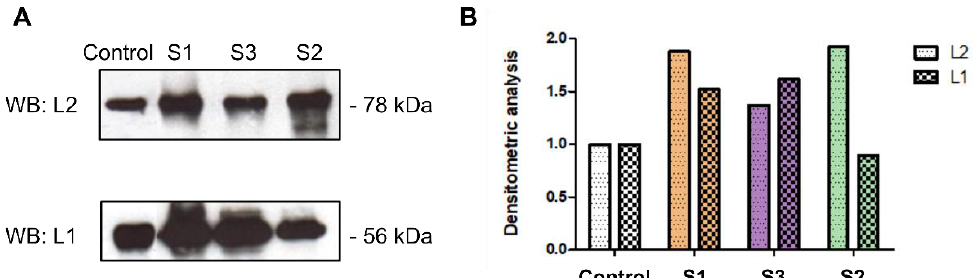
Figure 2. Effect of crude C. majus latex, protein fraction, and alkaloid-rich fraction on HaCaT cell viability. Consecutive numbers (1–7) on the x axis correspond to different protein concentrations in the crude latex (S1) and protein fraction (S2) applied on cells: 1 = 4.0 × 10 − 4 mg/mL, 2 = 8.0 × 10 − 4 mg/mL, 3 = 1.6 × 10 − 3 mg/mL, 4 = 8.0 × 10 − 3 mg/mL, 5 = 1.6 × 10 − 2 mg/mL, 6 = 4.0 × 10 − 2 mg/mL, 7 = 8.0 × 10 − 2 mg/mL. In the case of alkaloid fraction (S3), consecutive numbers (1–7) correspond to its different dilutions: 1 = 5 × 10 − 4 , 2 = 10 − 3 , 3 = 2 × 10 − 3 , 4 = 10 − 2 , 5 = 2 × 10 − 2 , 6 = 5 × 10 − 2 , 7 = 10 − 1 . They were obtained from series of dilutions from concentrated samples. Among the tested samples, the crude latex and the alkaloid-rich fraction showed the strongest cytotoxicity in the range of 8.0 × 10 − 3 –8.0 × 10 − 2 mg/mL (numbers 4–7), and the protein fraction exerted lowest toxicity against HaCaT cells in this concentration range. Most of the tested samples in the range of 4.0 × 10 − 4 –1.6 × 10 − 3 mg/mL (numbers 1–3) showed the lowest cytotoxicity.